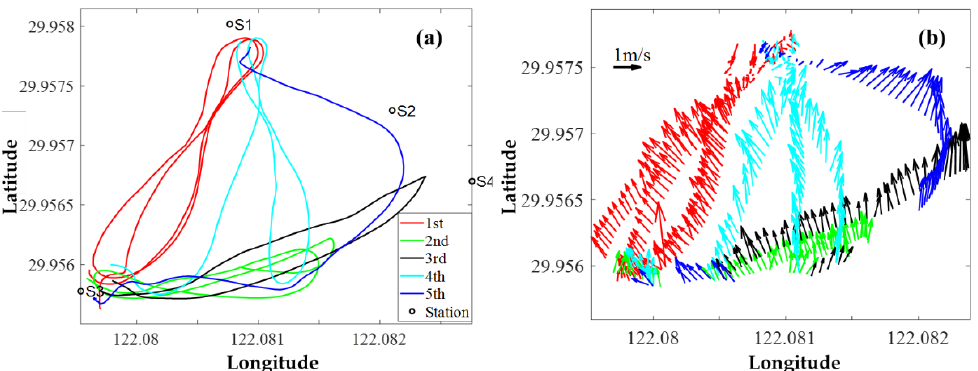
Table 3. Acoustic Doppler current profiler (ADCP) path and its corresponding time.